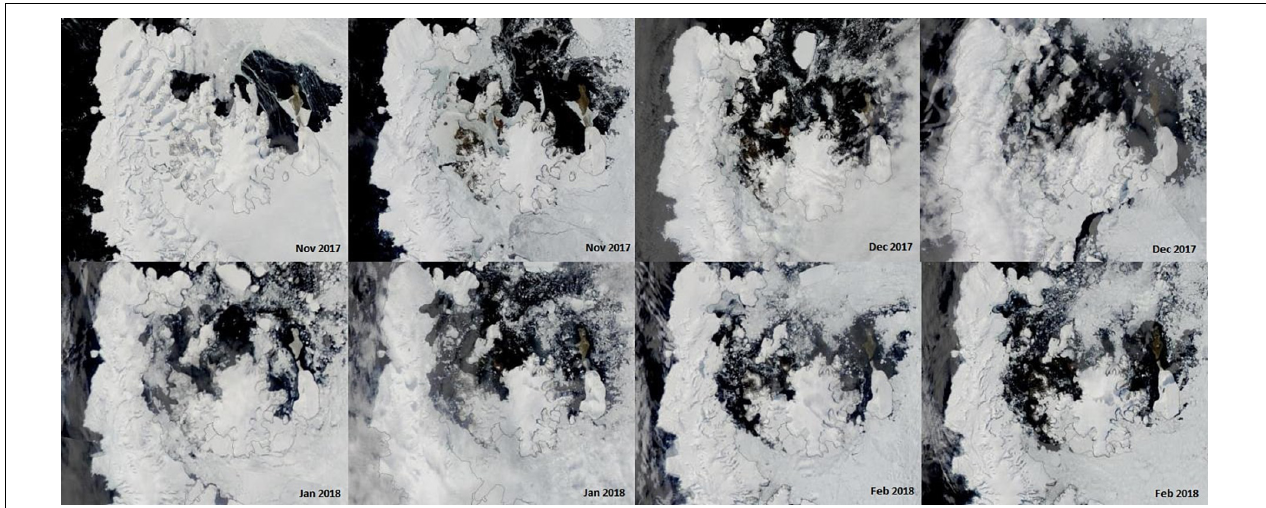
FIGURE 8 | From left to right, image sequence of ice melting in the Eastern Antarctic Peninsula during the four months preceding the JR17003a research campaign. Satellite images source: